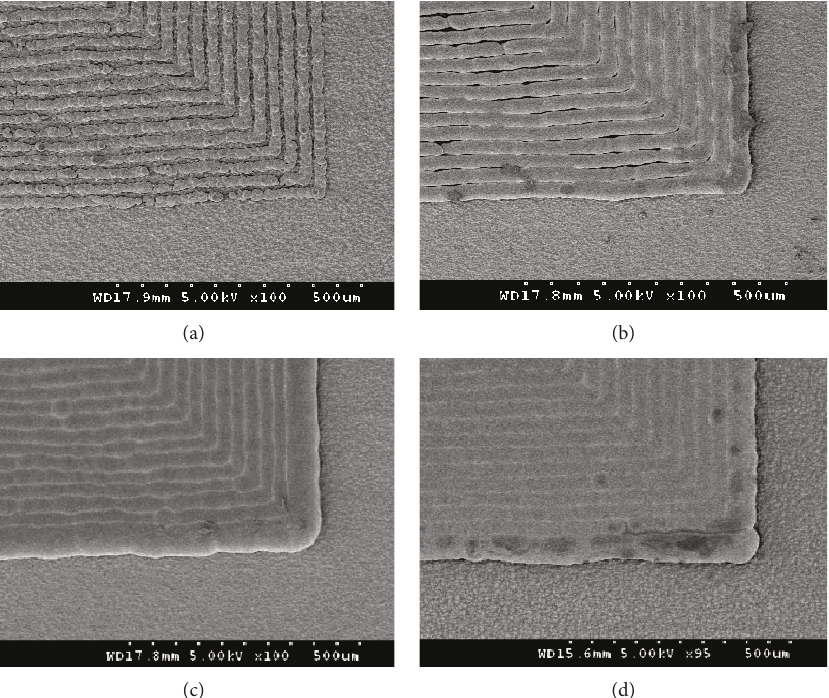
Figure 11: FESEM surface morphology images of backside surfaces of SPMSCs with various EPC times of (a) 20, (b) 30, (c) 40, and (d)